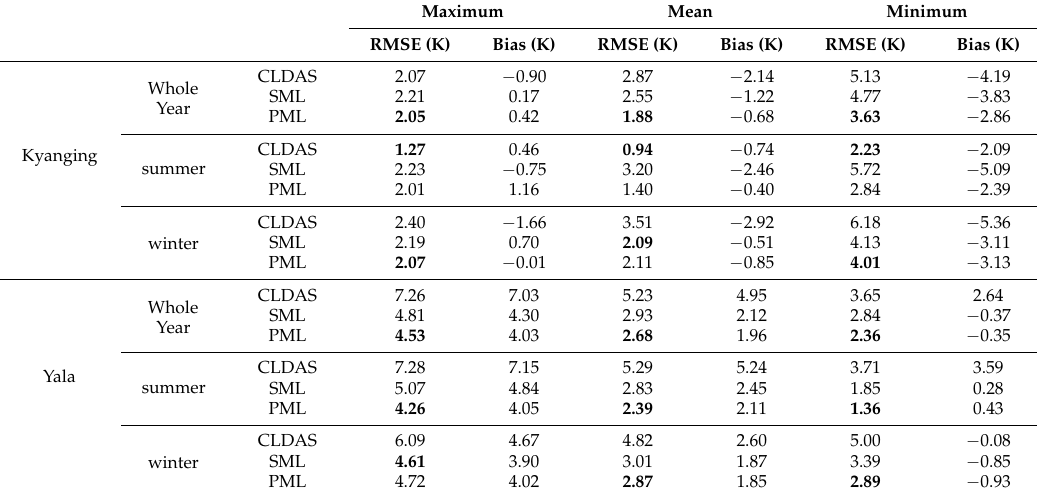
Table 1. The validation result of CLDAS, SML and PML estimated Ta benchmarked with station observation. Bolded values represent the best performances among the three Ta estimates. CLDAS represents China Meteorological Administration (CMA) land data assimilation system. SML is simple multi-variable linear regression method and PML is piecewise multi-variable linear regression method. Maximum Mean Minimum RMSE (K) Bias (K) RMSE (K) Bias (K) RMSE